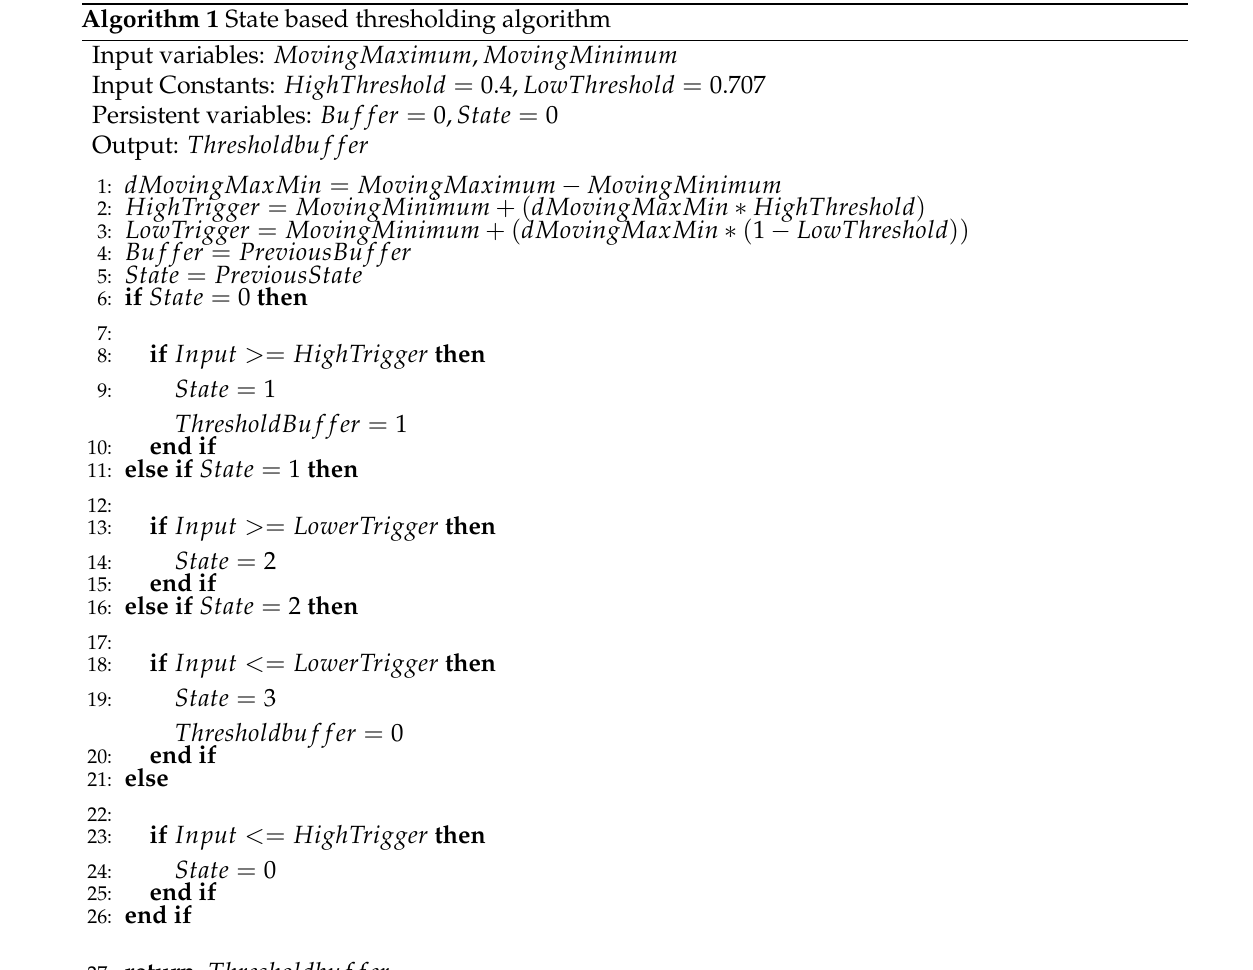
Algorithm 1 State based thresholding